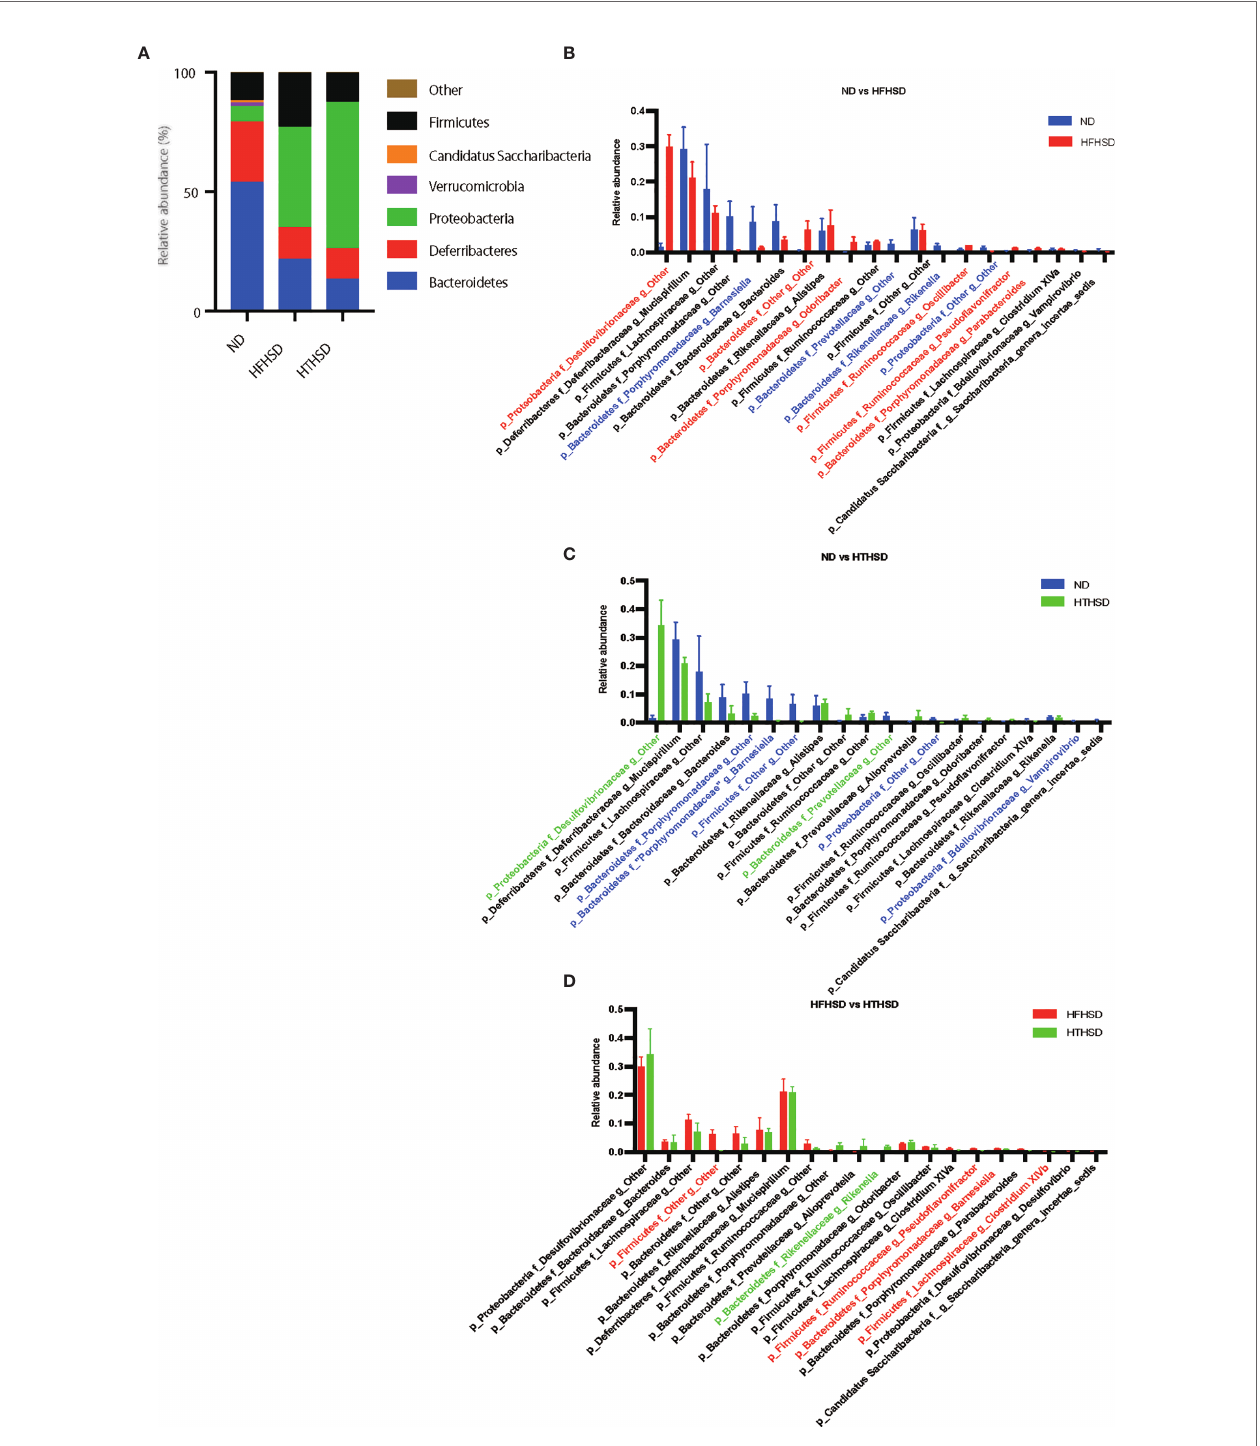
FIGURE 6 | Mice fed with HFHSD or HTHSD displayed signi fi cantly higher relative abundance of family Desulfovibrionaceae (which belongs to phylum Proteobacteria) than mice fed with ND. (A) Relative abundance of gut microbiota, by phylum. (B – D) Dominant gut microbial genera. The in fl uence of genera of unique gut microbiota in mice fed with ND, HFHSD, or HTHSD was assessed using the weighted average differences method, followed by ranking of the assessed in fl uence of genera from top to bottom. The top 20 gut microbial genera are shown. Relative abundance of gut microbiota in the two groups was compared using an unpaired, two-tailed Student ’ s t test. Gut microbiota with signi fi cantly higher abundance in a group have been indicated in the color of the group. Red : ND, Blue : HFHSD, Green :